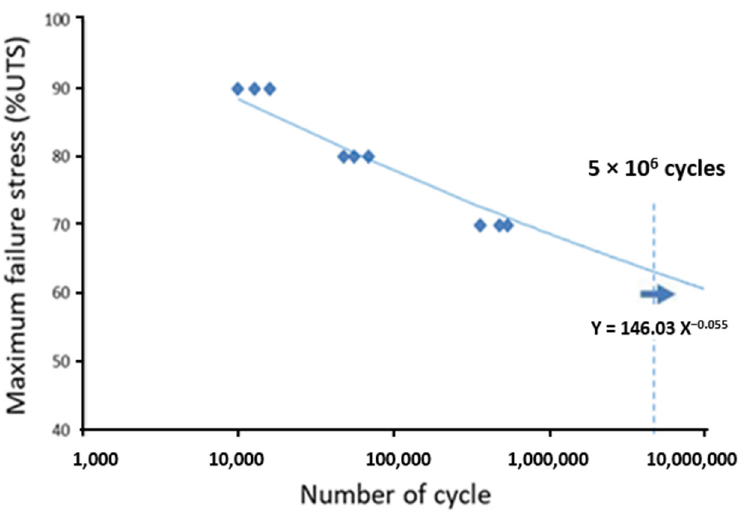
Figure 11. Experimental Wöhler curve (also known as S–N curve). Adapted from [21].